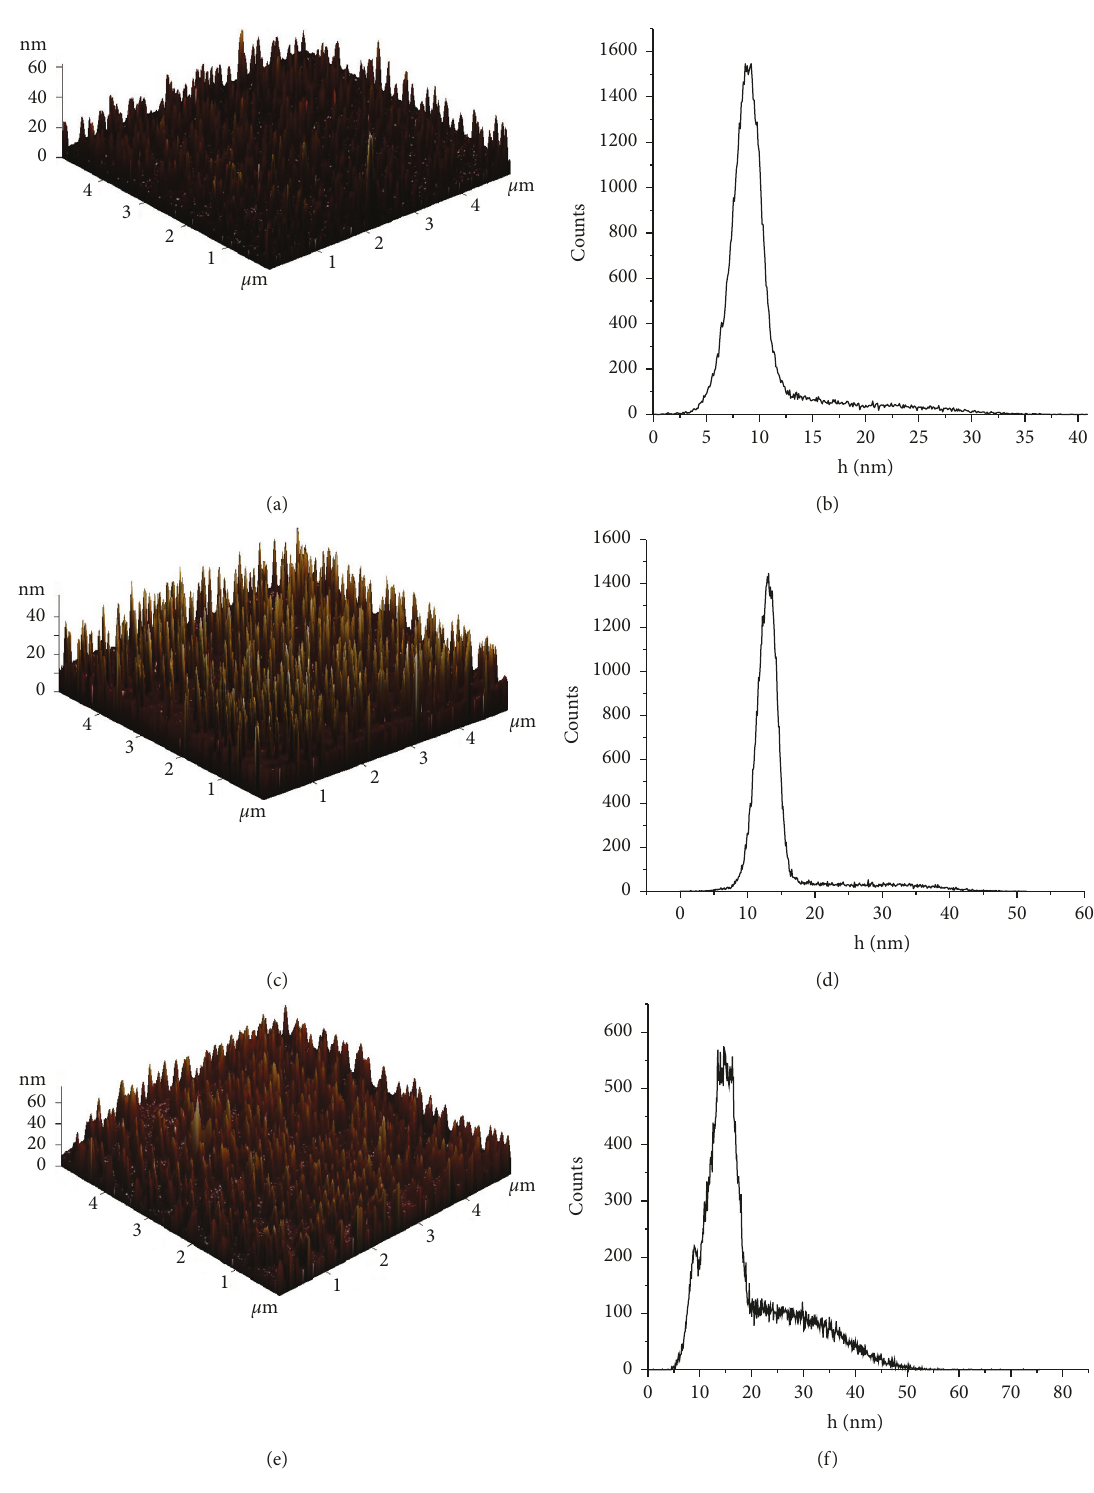
Figure 4: AFM images of PdNPs obtained by electrolysis in a solution containing 4mM of Pd(NO E cathode � − 2.0V after 25 (a), 50 (c), and 400 (e) cycles and the height distribution histograms of PdNPs (b, d, and